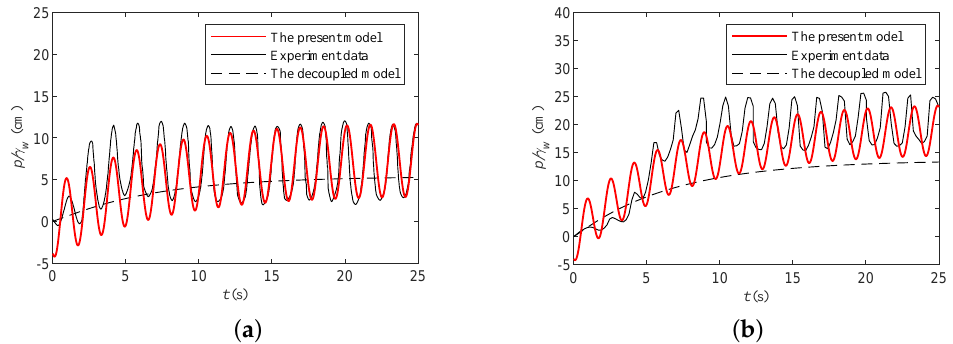
Figure 5. Comparison of the wave-induced pore pressure obtained from the present coupled model with results from experiments [15] and decouple model [18]; ( a ) z = − 0.085 m; ( b ) z = − 0.24 m.